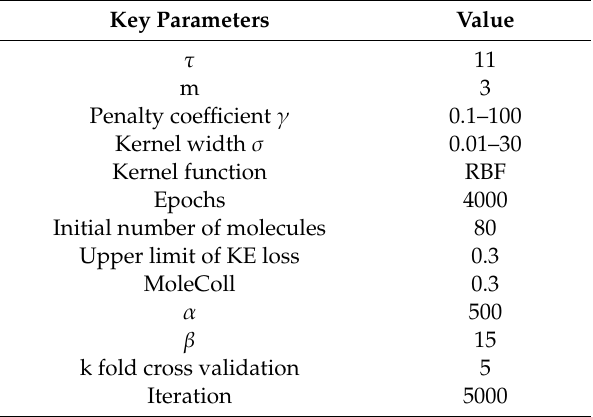
Table 3. Key parameters of PSR-CRO-WLSSVM forecasting model. Key Parameters